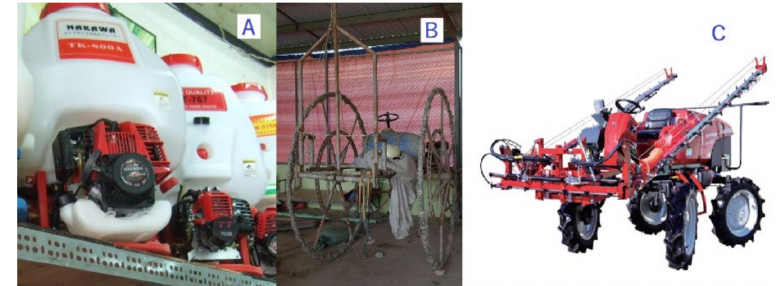
Figure 10. Agrochemical sprayers, ( A ): Semi-mechanized chemical sprayer sold in Vietnam; ( B ): Local made riding type sprayer; ( C ): Riding type sprayer imported and sold in Vietnam. Source: Photos A and B were taken by the author at An Giang province on 5th September 2014; photo C is from a catalogue of a Japanese manufacturer [28].